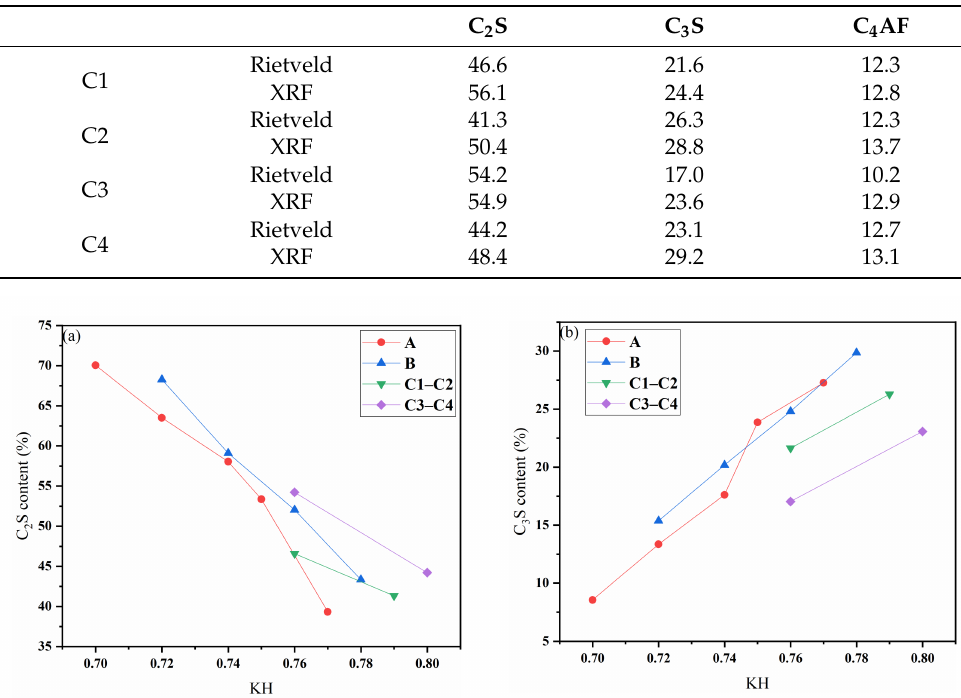
Table 8. Phase composition (wt.%) of C1–C4 sintered at 1350 ◦ C, for 30 min.